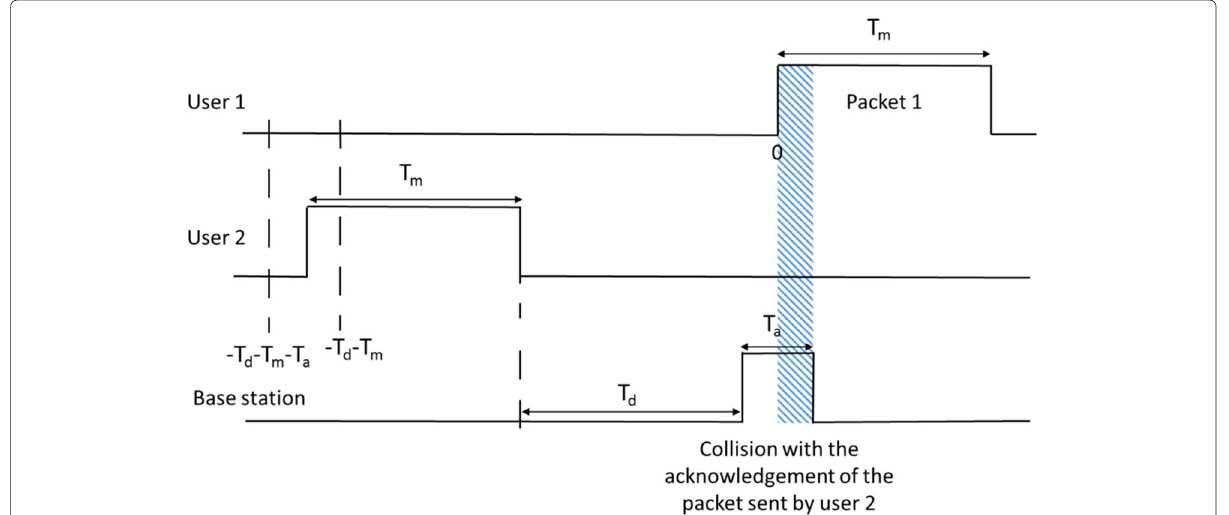
Fig. 5 Example of collision between an uplink packet and an acknowledgement sent by the base